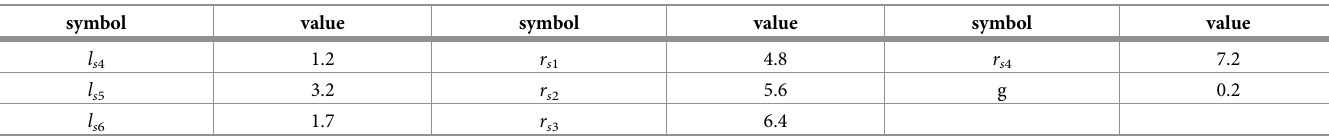
Table 5. TONCTR dimensions in millimetres (mm).